Question: Condense the content of this figure into a single sentence.
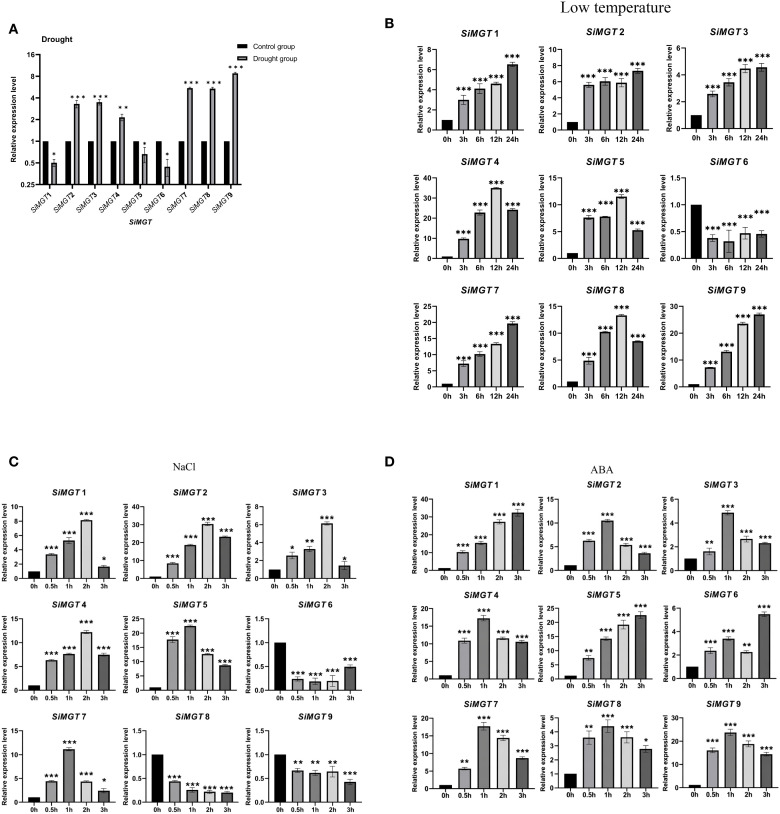
Answer: Expression patterns of SiMGT genes under abiotic stresses. (A) Drought stress; (B) Low-temperature stress; (C) Salt stress; (D) ABA stress. Relative expression levels are normalized to the control (0 h/min). Data are presented as mean ± SD of three biological replicates. *P < 0.05, **P < 0.01, ***P < 0.001 (one-way ANOVA with Duncan’s multiple comparison test).